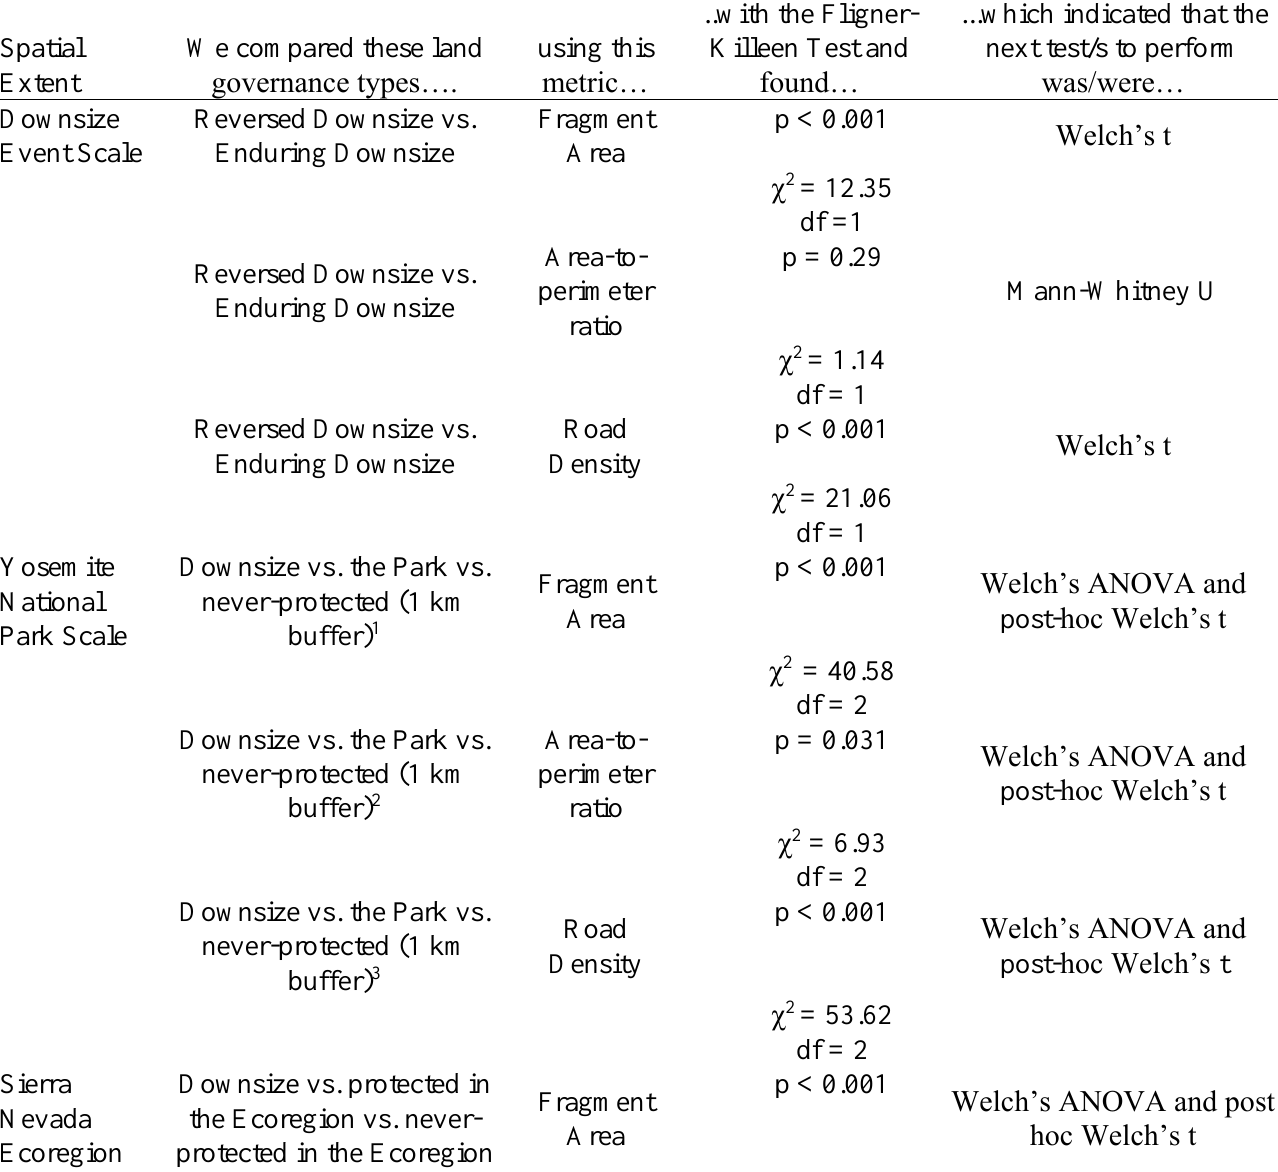
Table A1.3: Results of Fligner-Killeen tests for homoscedasticity for forested lands indicating which statistical test(s) to perform next at all three spatial